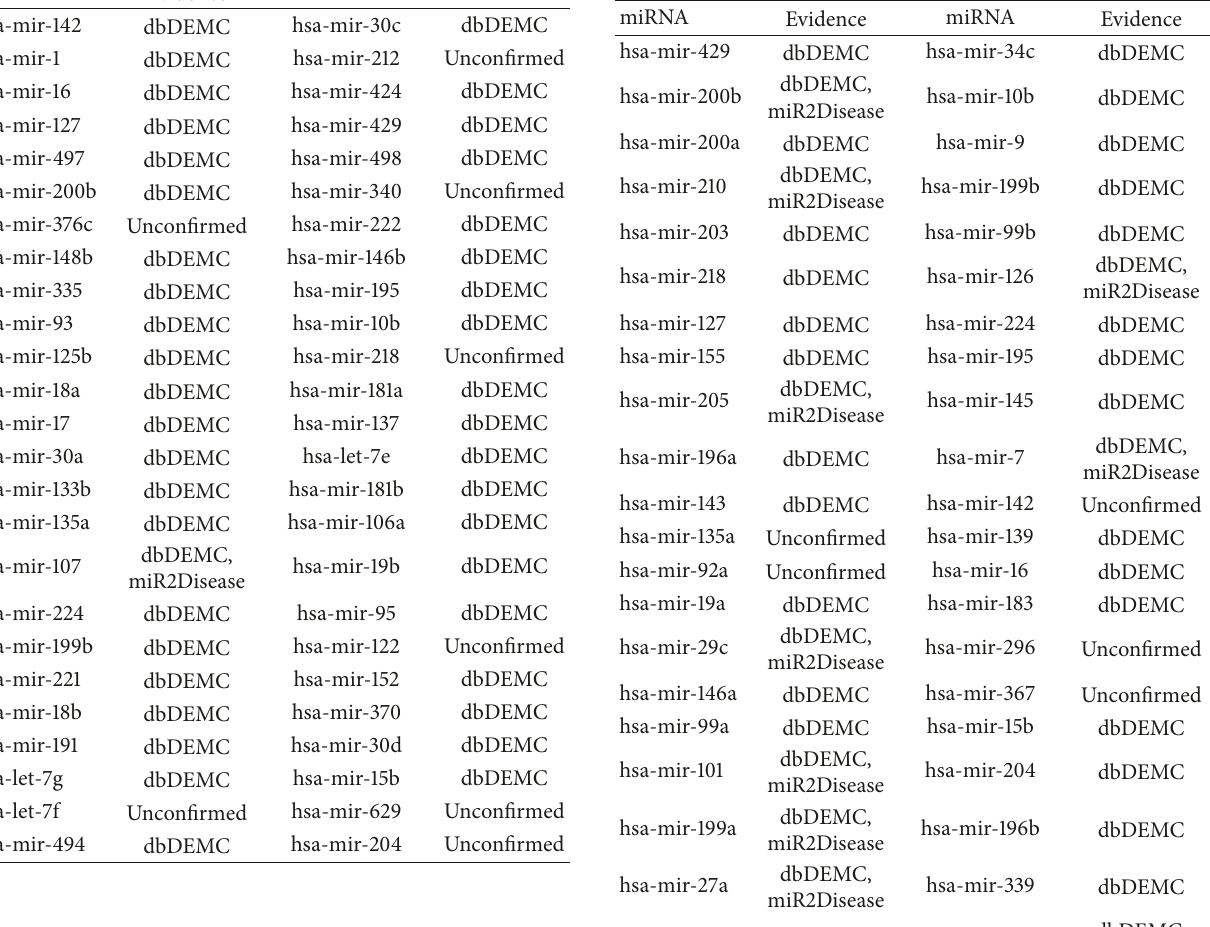
Table 1: We implemented CMFMDA to predict potential Esophag- ealNeoplasms-relatedmiRNAs.Asaresult,9outofthetop10and42 out of the top 50 predicted Esophageal Neoplasms related miRNAs were confirmed based on miR2Disease and dbDEMC (1st column: top 1–25; 2nd column: top 26–50).